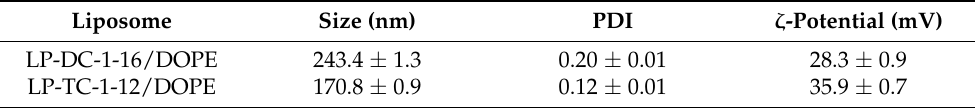
Table 3. Size and ζ -potential of mRNA lipoplexes for in vivo transfection.